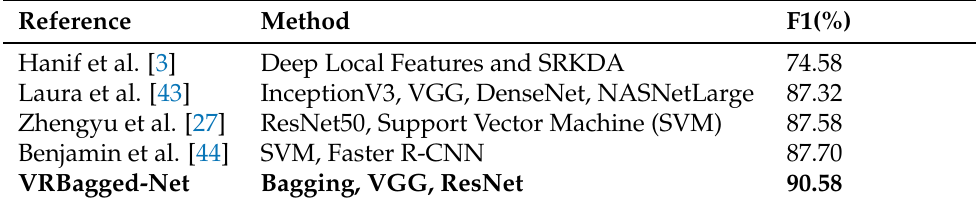
Table 3. FCSM Dataset: Comparison of VRBagged-Net with state-of-art